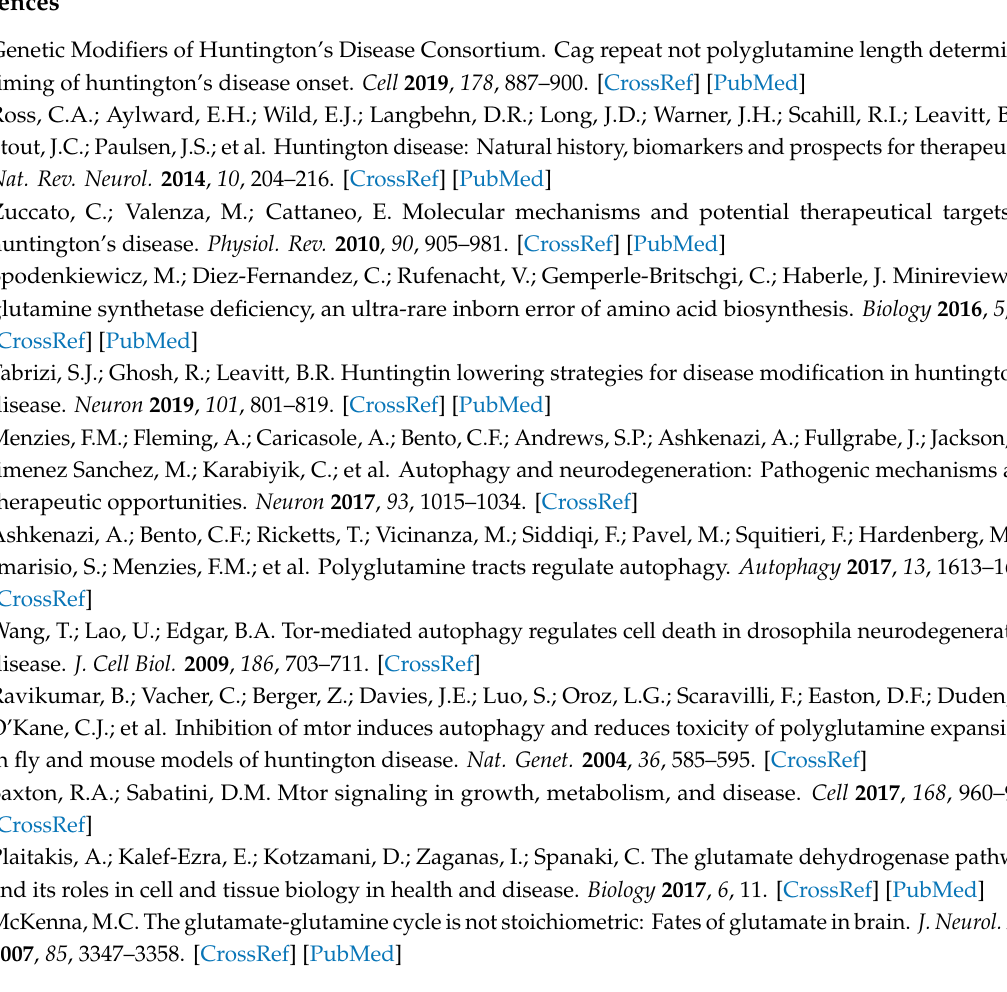
rescues animal survival (A) but not climbing defects (B) induced by elav c155 -Htt-Q93 in adult males; Supplementary Figure S7: MSO (methionine sulfoximine) specifically inhibits GS1 activity in lysates from heads of elav c155 /+ and elav c155 /+ ; EP GS1 G3347 females; Supplementary Figure S8: Co-expression of GS1 with Htt-Q93 in neurons partially rescues the climbing defects induced by expression of elav c155 -Htt-Q93 visible in adult females, using two others independent recombinant Htt-Q93 , GS1 lines; Supplementary Figure S9: E ffi ciency of Atg1-RNAi and Atg5-IR 24-1 in reducing autophagic puncta and the relative protein expression in adult heads. Supplementary Figure S10: Expression of elav-Atg8-mCherry in the calyx of third instar larval brains. Supplementary Excel-file 1: ANOVA analysis; Supplementary Video S1: larvae elav-Htt-Q16 ; Supplementary Video S2: larvae elav-Htt-Q93 ; Supplementary Video S3: adult climbing elav-Htt-Q93 and elav-Htt-Q16